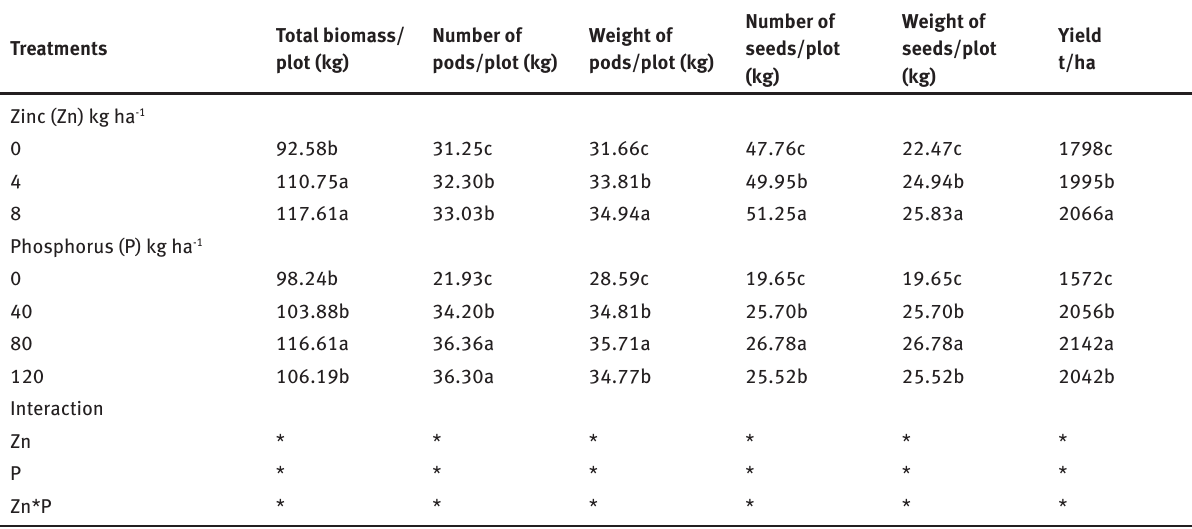
Table 3: Effect of Zn and P fertilizers on the yield and yield parameters of groundnut based on the mean from 2017 and 2018 cropping seasons